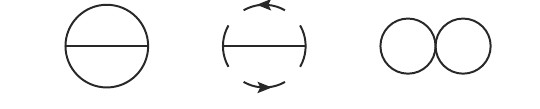
Fig. 2 Two-loop contributions to W h [ B